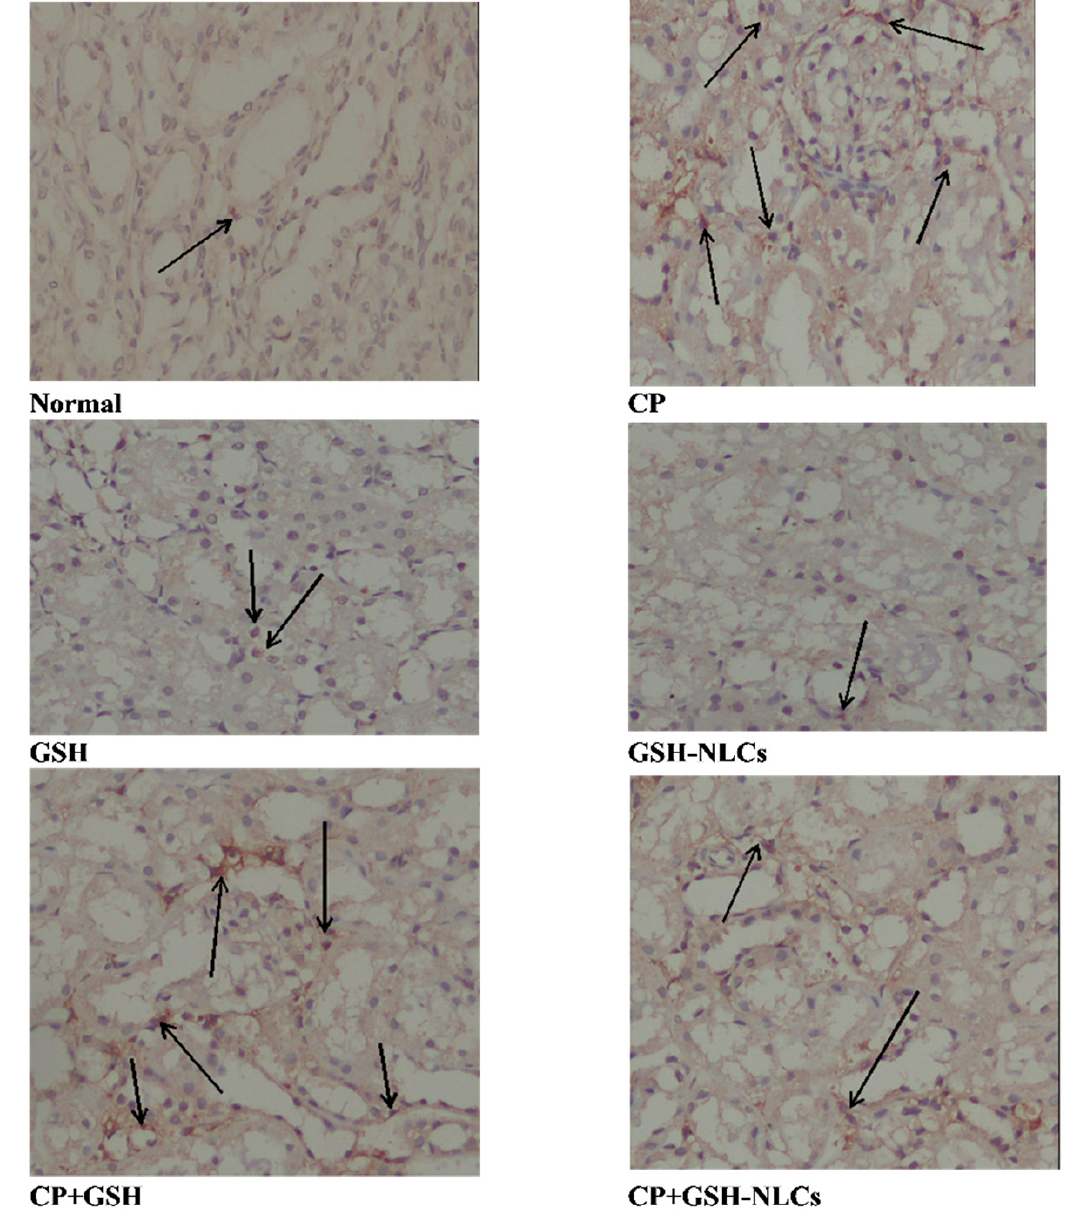
Figure 8. Immunohistochemistry results of NF-K β on renal tissue of Normal = Normal rats; CP = Cyclophosphamide- injured rats; GSH = glutathione-treated rats, GSH-NLCs = nano-glutathione-treated rats; CP+GSH = Cyclophosphamide + Glutathione-treated rats; CP+GSH-NLCs = Cyclophosphamide + nano-glutathione-treated rats (magnification ×200).